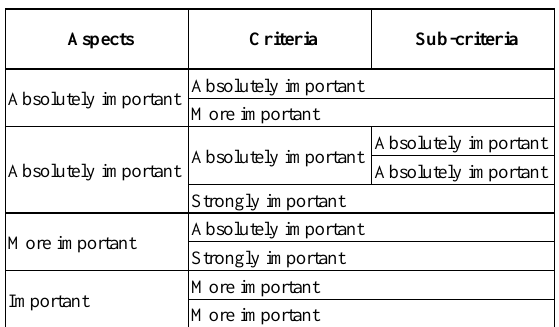
Table 5. The weights of aspects and criteria